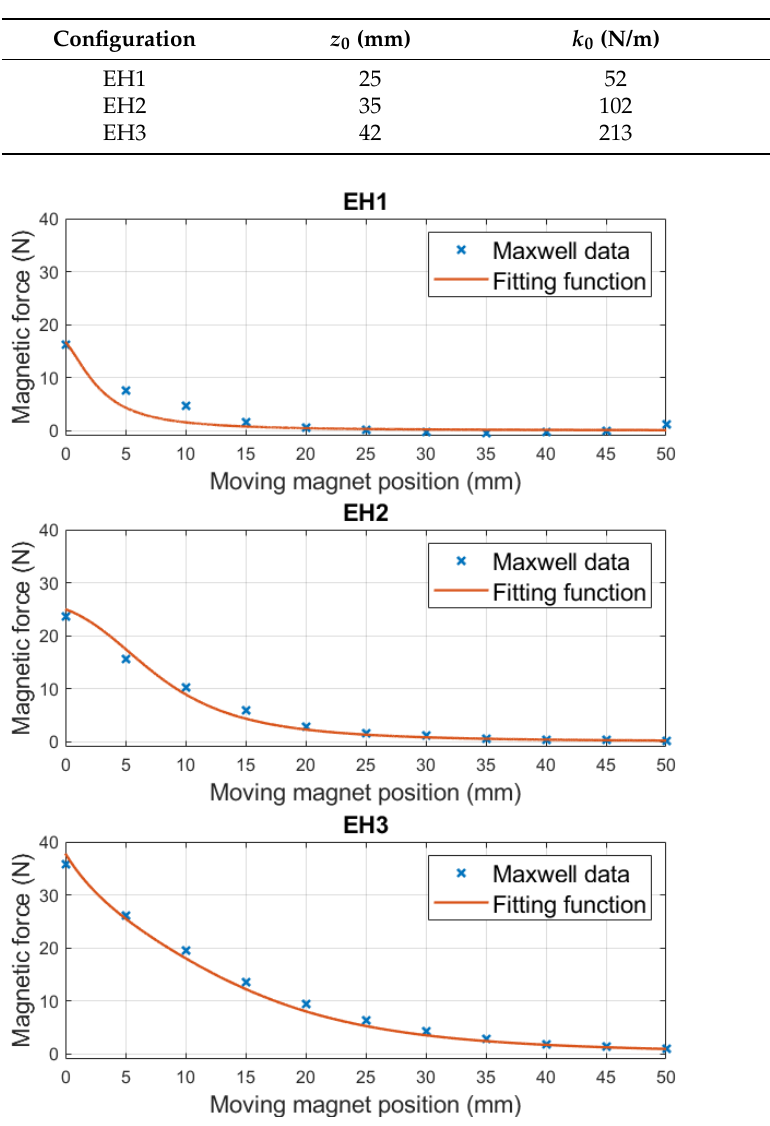
Figure 5. Magnetic force curves for EH1, EH2, and